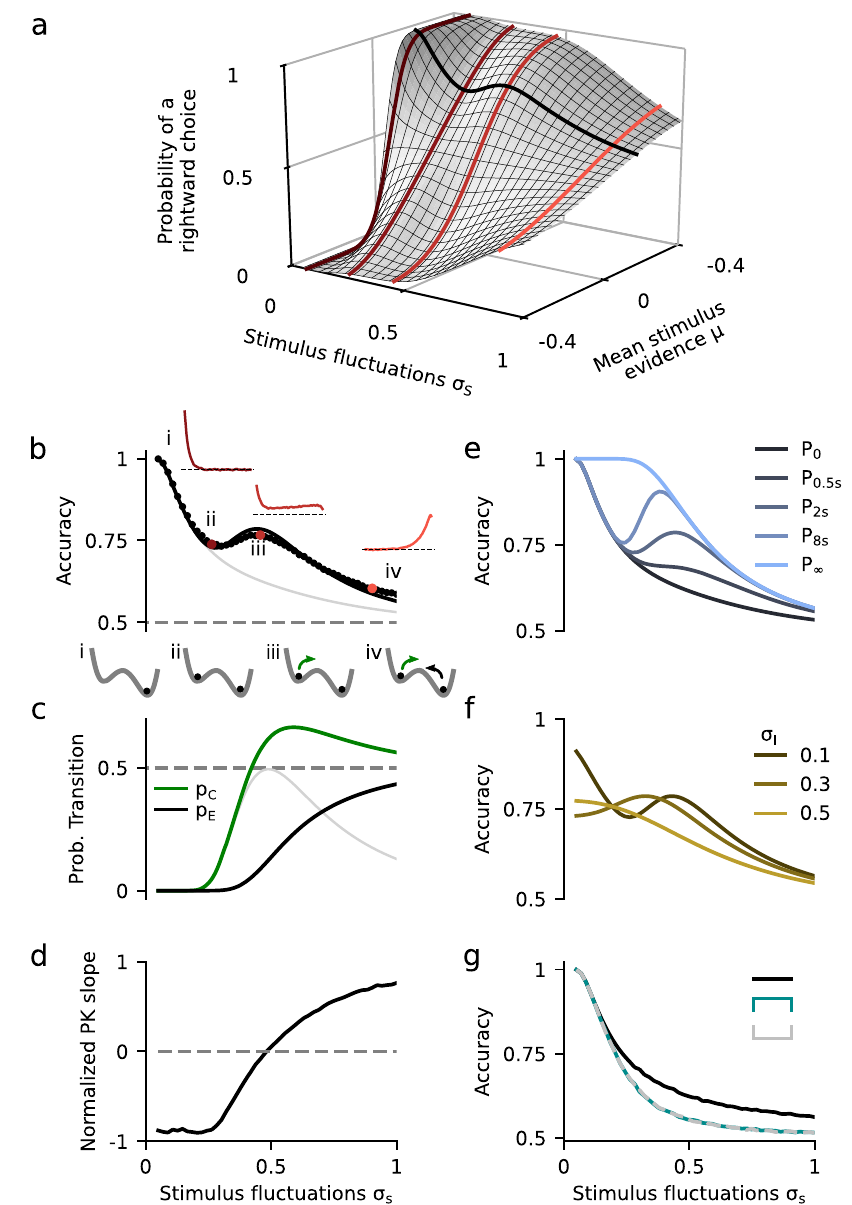
Fig. 3 Impact of stimulus fl uctuations on choice accuracy in the double well model. a Probability of a righward choice as a function of the mean stimulus evidence ( μ ) and the stimulus fl uctuations ( σ S ). The colored lines show classic psychometric curves, accuracy versus μ (for fi xed σ S = 0.07, 0.26, 0.46, and 0.90) whereas the black line shows the accuracy versus σ S (for fi xed μ = 0.15). b Accuracy ( P ) as a function of the stimulus fl uctuations σ S obtained from numerical simulations (dots) and theory (line, same as black line in a ). Insets show the PK for three values of σ S (marked with colored dots). The gray line shows the accuracy of the fi rst visit attractor ( P 0 ). c Probability to make a correcting p C (green) or an error transition p E (black) and their difference p C − p E (gray). The local maximum in P coincides with the maximum difference between the two probabilities. Insets: sequence of regimes as transitions become more likely: (i) For negligible σ S , the decision variable always evolves towards the correct attractor; (ii) as σ s increases, the decision variable can visit the incorrect attractor but neither kind of transition is activated; (iii) for stronger σ S , only the correcting transitions (green arrow) are activated; (iv) for strong σ σ fl exible categorization regime, reached when the index is close to S , both types of transition are activated. d Normalized PK slope as a function of S . The zero, coincides with the local maximum in accuracy ( a ). e Accuracy versus σ S for different stimulus durations T (see inset). The accuracy for any fi nite T shifts as σ S increases between the probability to fi rst visit the correct attractor P 0 and the stationary accuracy P ∞ . f Accuracy versus σ S for different magnitudes of the internal noise (see inset). g Accuracy versus σ S for the three canonical models (see inset). The internal noise was σ i = 0 in all panels except in f